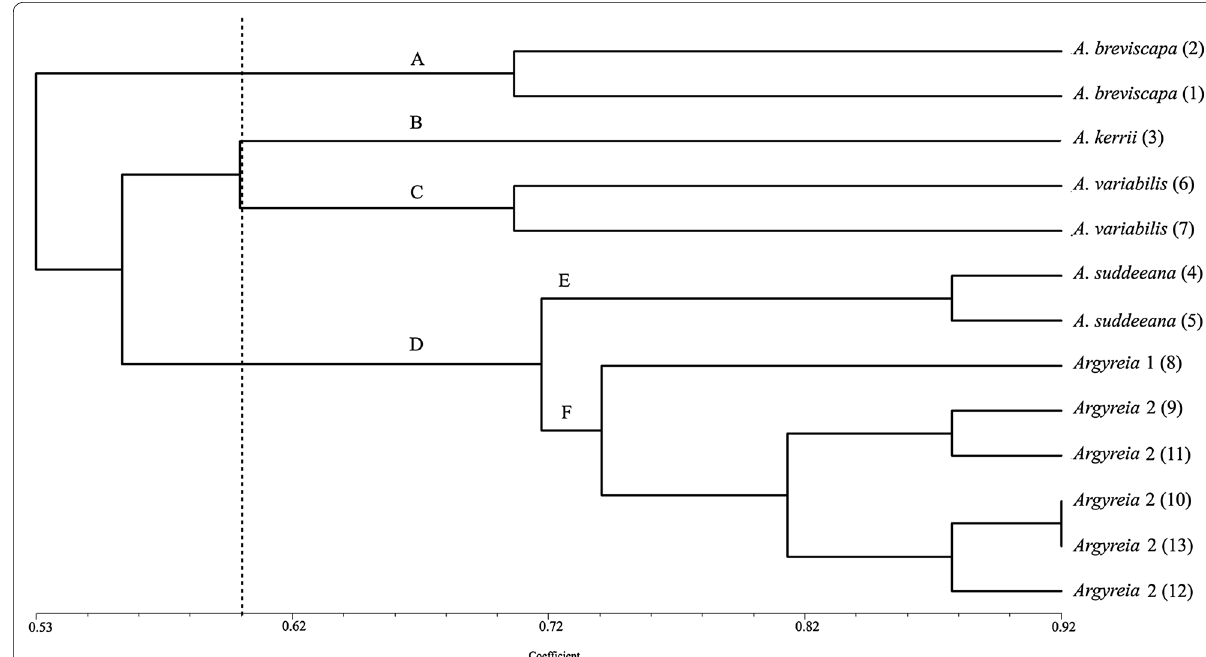
Fig. 6 Phenogram for six Argyreia morpho-types from cluster analysis based on UPGMA method using 24 anatomical traits; the vertical dashed line indicates similarity coefficient; parenthetical numbers ( 1 )–( 13 ) indicate accession number of plant materials cited in Table